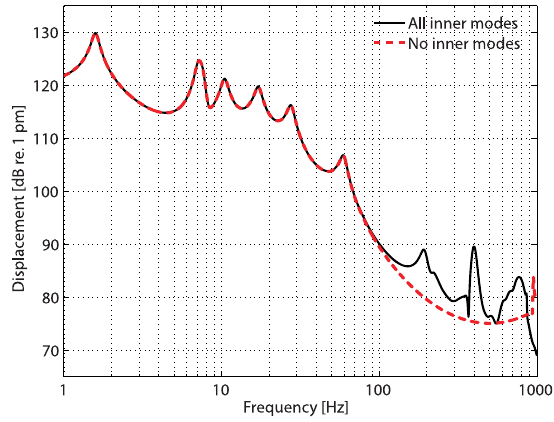
Fig. 14. Relative difference from the direct solution of the solution us- ing no inner modes (dashed line) and the solution using all modes with an eigenfrequency below 2 kHz (solid line),